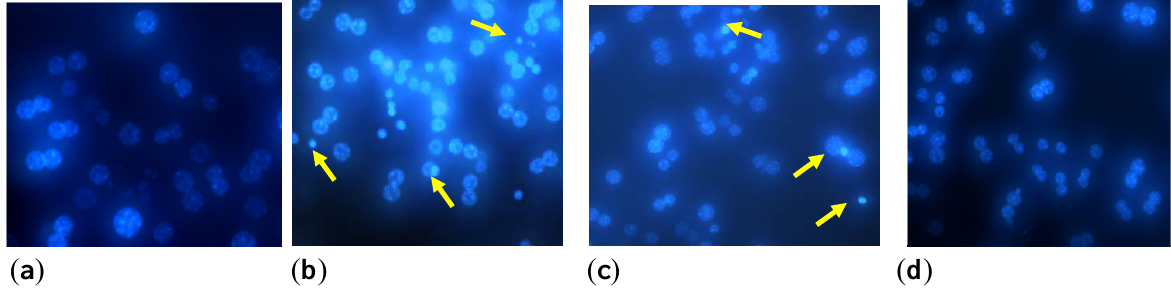
Figure 3. Fluorescence microscope images of hydroquinone-untreated ( a ) or treated ( b ) hepatocytes stained by Hoechst 33342. In comparison with the negative control ( a ), 48 h treatment of hydroquinone ( b ) caused morphological shrinking in hepatocytes, and apoptotic bodies and chromatin condensation were formed (indicated by arrows). Pretreatment by ( c ) 0.5 mM or ( d ) 1 mM of resveratrol 1 h before hydroquinone exposure inhibited hydroquinone-induced